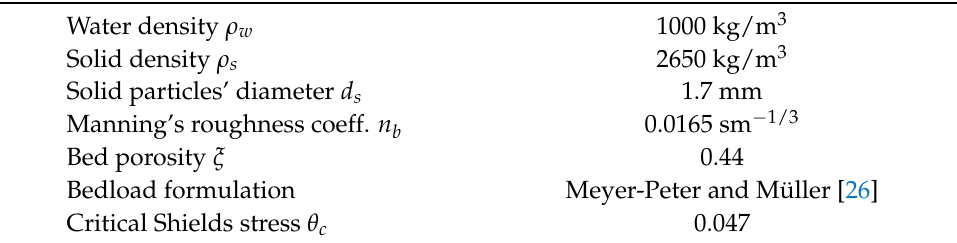
Table 3. Setup of the